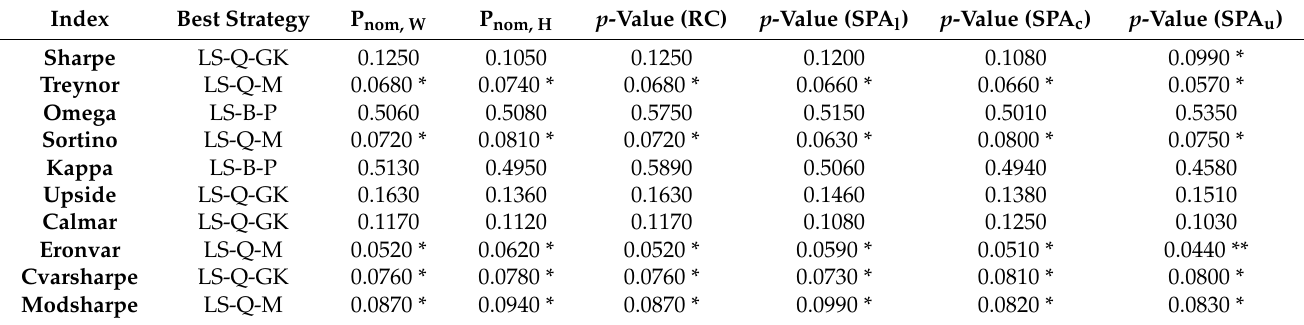
Table 9. Data snooping tests.